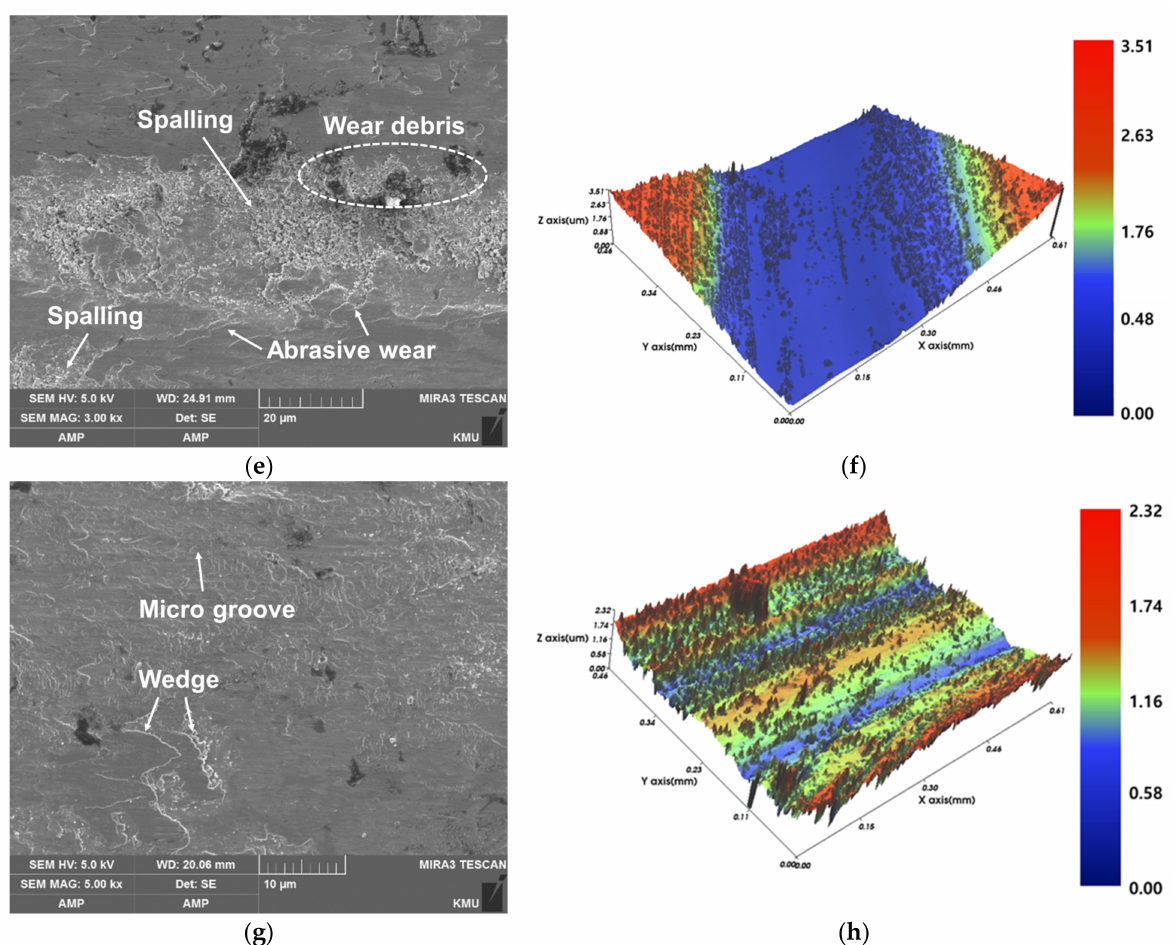
Figure 11. SEM micrographs and 3D topographies of the worn surface: ( a , b ) C-SCM420, ( c , d ) as-built (M2), ( e , f ) as-built (FeCrVMoW), ( g , h ) as-built